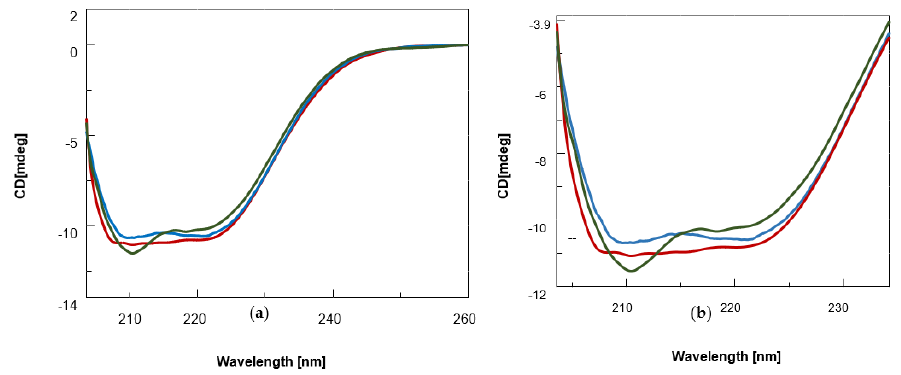
Figure 2. ( a ) CD spectra of BSA (0.12 μ M, blue) and its complexes with the benzofuran derivatives (25 nmol) BF1 (dark green) and BDF1 (red) in 90 mM NaCl, 1.8 mM KCl, 6.6 mM Na 2 HPO 4 , and 1.2 mM KH 2 PO 4 (pH = 7.5) at 20 ◦ C. ( b ) Zoomed-in view of the CD bands between 200–235